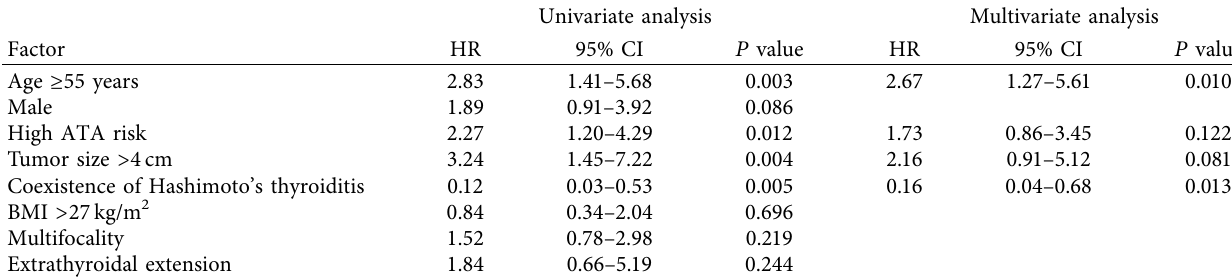
Figure 2: The prevalence of papillary thyroid microcarcinoma classified by ATA risk in each decade of the study period. Table 3: Potential factors of persistent/recurrent papillary thyroid